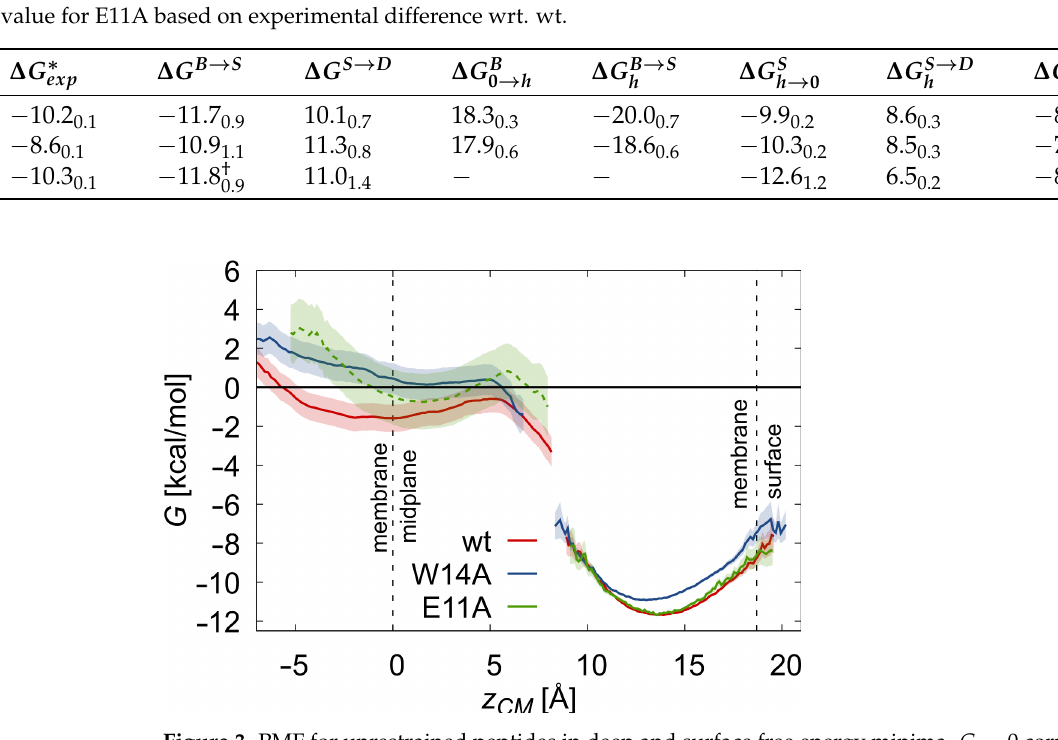
Figure 3. PMF for unrestrained peptides in deep and surface free energy minima. G = 0 corresponds to free peptides in the aqueous phase. Relative depths of free energy wells for surface and deep configurations were obtained based on: continuous PMF for restrained peptides, (un)restraining free energy calculations, and free peptides simulations (Table 1 and Figure S4). Dashed line for E11A reflects the fact that its surface minimum was estimated based on binding free energy for